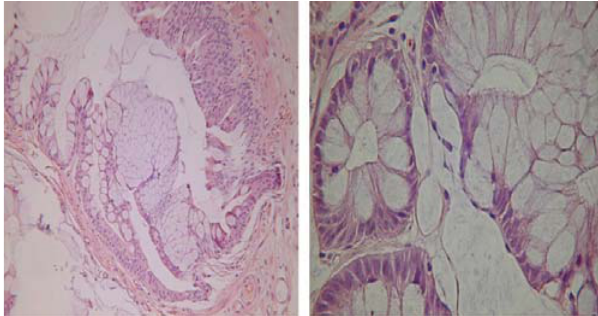
pattern (B) High cylindric cells with polarized nuclei inferiorly, large cytoplasm, clear, and full of mucus.